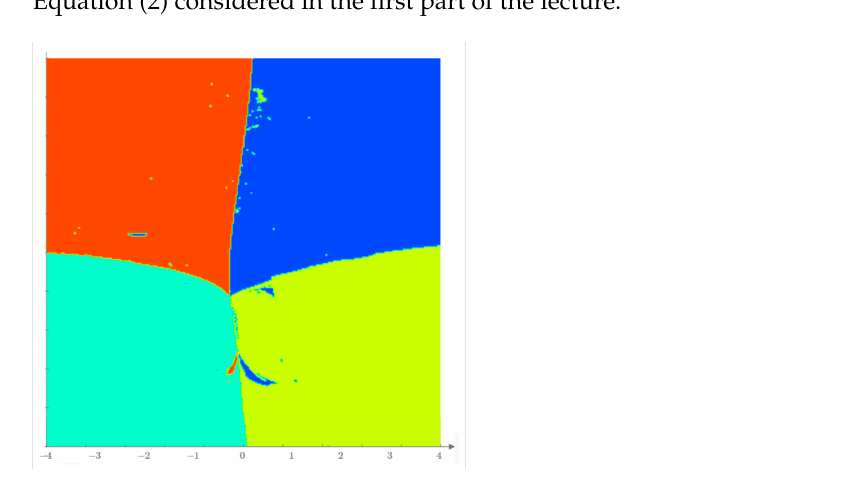
Figure 20. “Portrait” of the numerical search for the minima of the Himmelblau’s function using the Levenberg–Marquardt